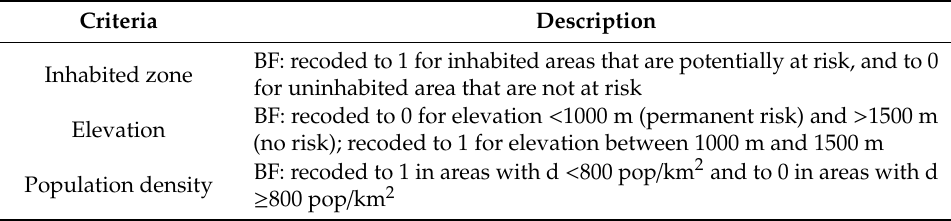
Table 2. Constraint descriptions and parameters.